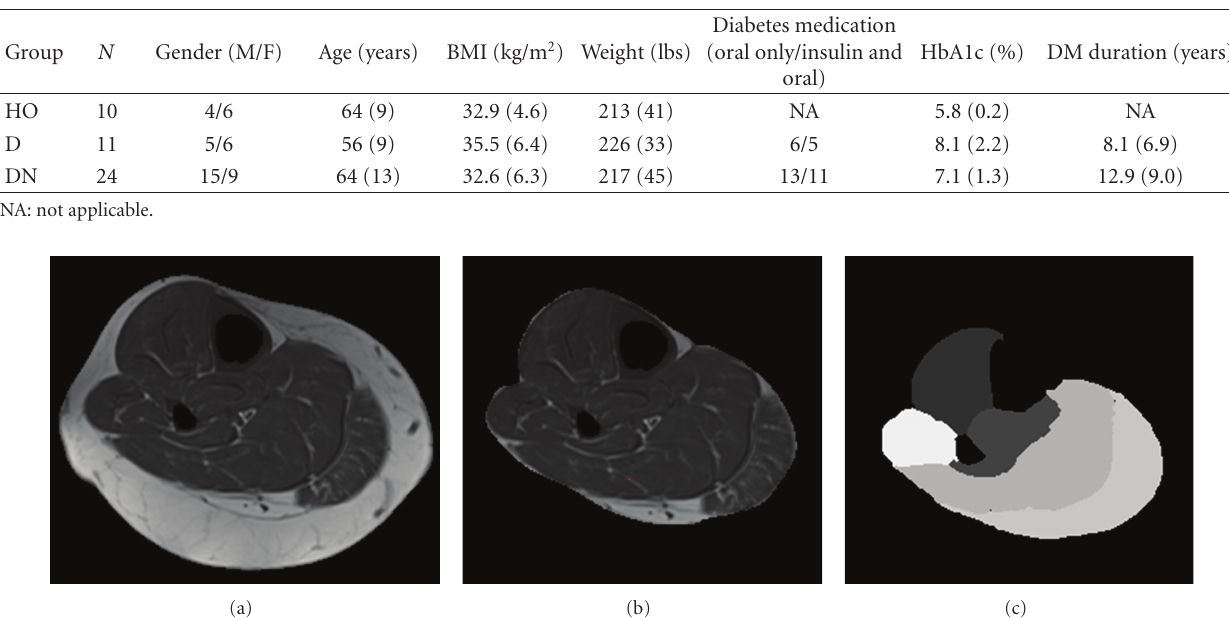
Table 1: Subject demographics by group. Values are means (SD).